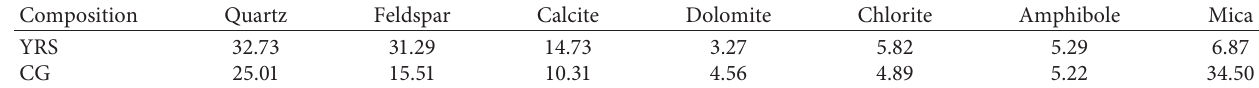
Table 2: The chemical properties of YS and CG